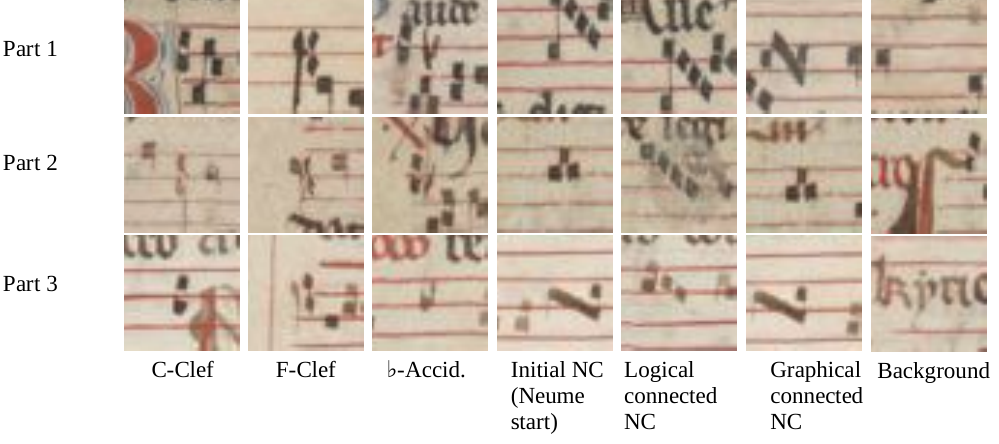
Figure 8. Each column shows cropped instances of the seven classes to be recognised by the symbol detection, respectively for each data set part. The central pixel position defines the type.